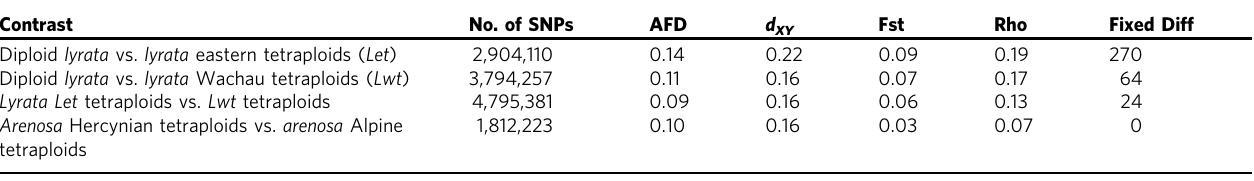
Table 1 Genome-wide differentiation between A. lyrata diploids and tetraploids, and between tetraploid lineages grouped by